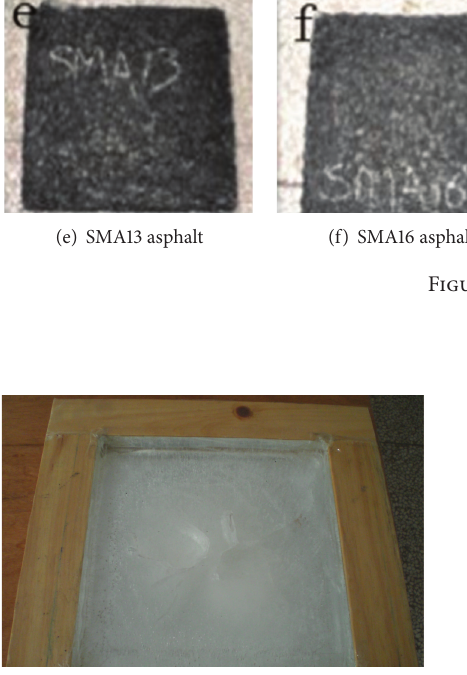
Figure 3: Ice road samples.